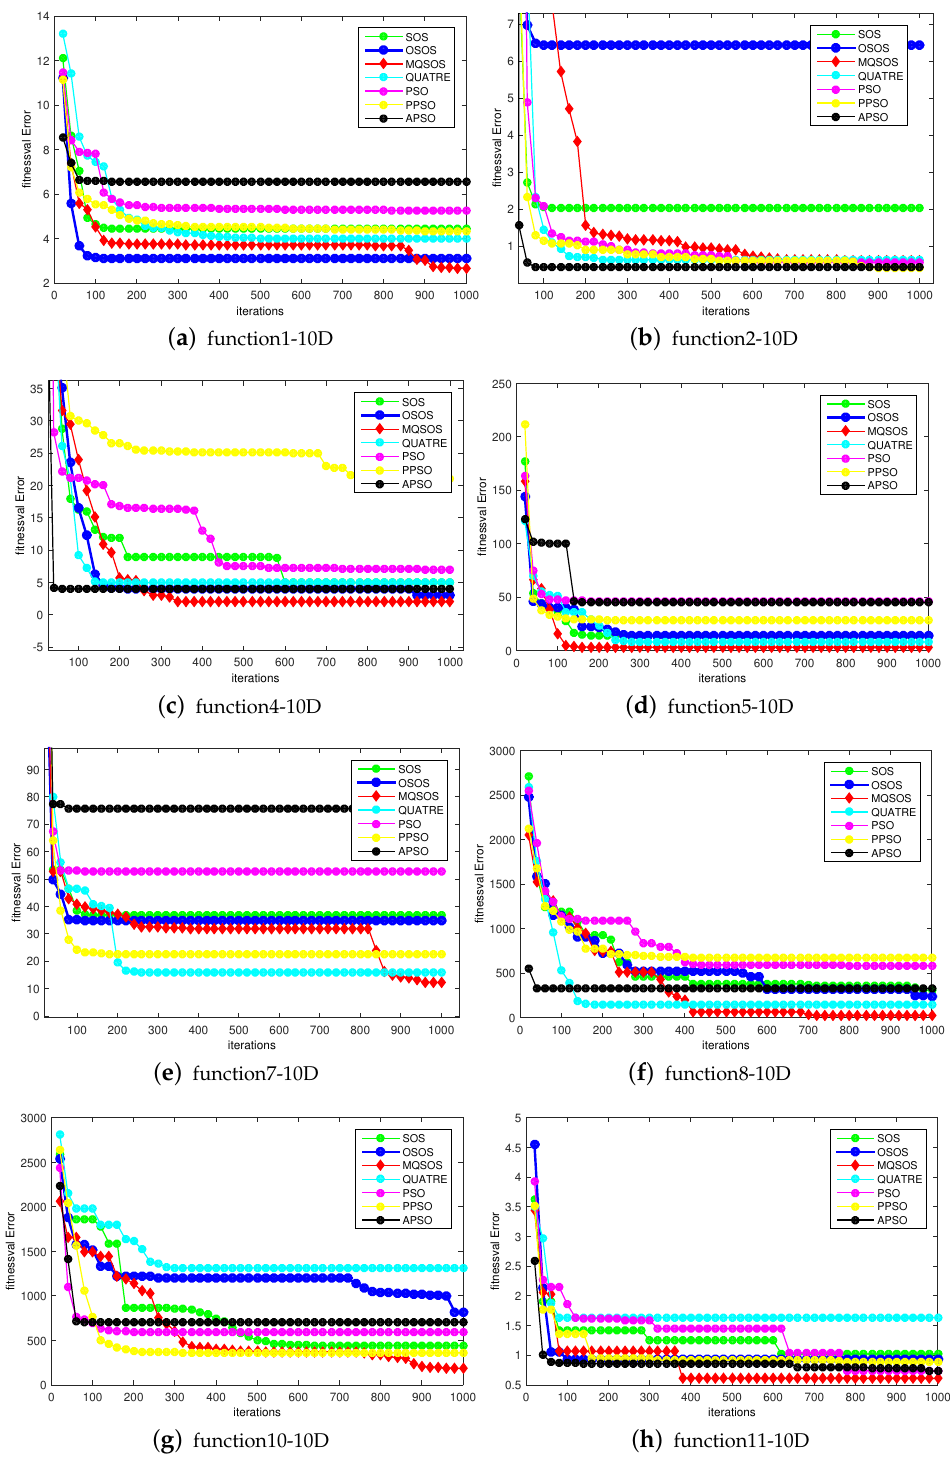
Figure 3. Comparison of the best fitnesses for functions f 9 − f 16 with 10D